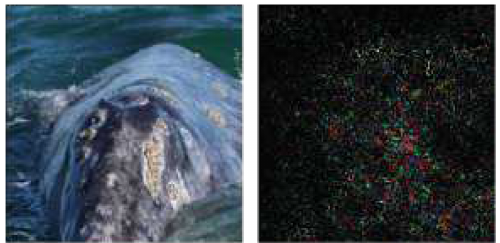
Figure 1. DeepFool [8] examines the robustness of neural networks. Very small noisy images were added on correctly classified images; humans cannot see the difference, but the model changes its prediction: x ( left ) is correctly classified as whale, but x + r as turtle; r ( right ) is very small.